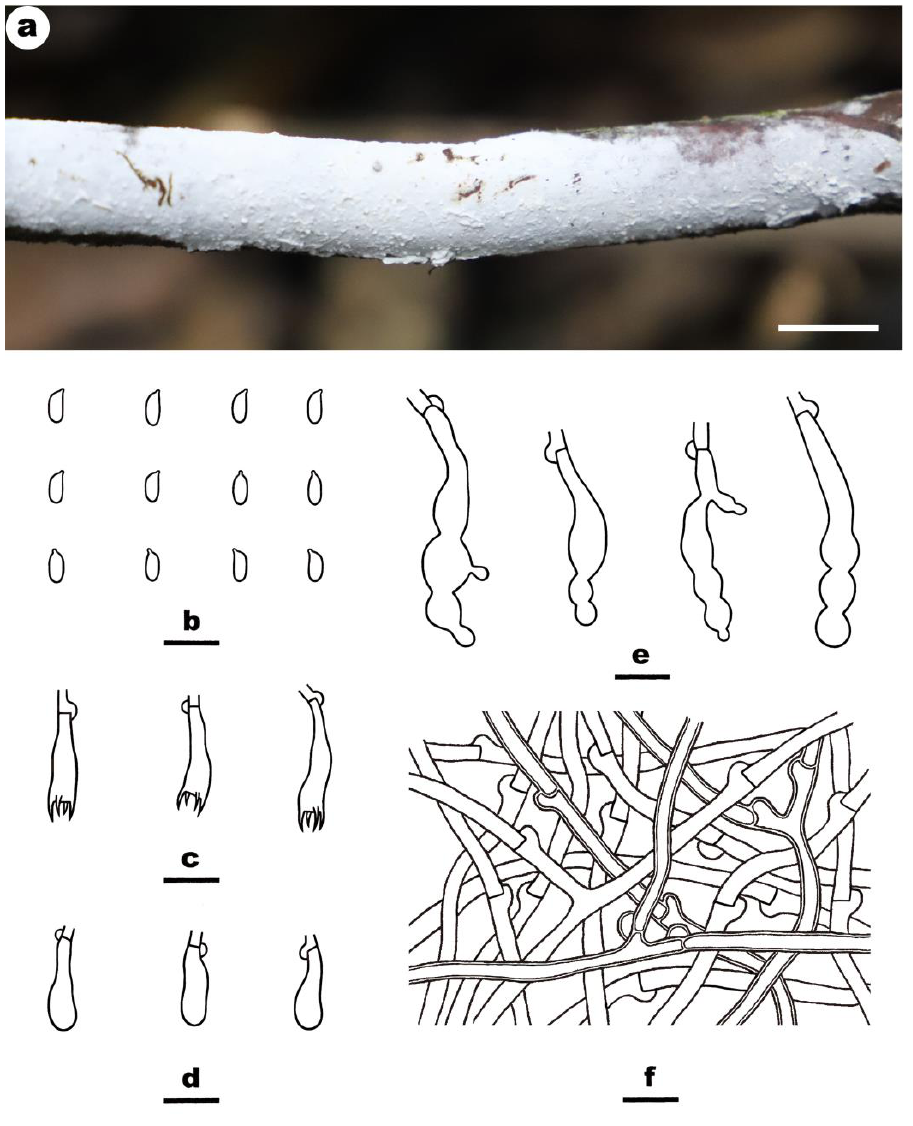
Figure 3. Crustomyces albidus (from the holotype BJFC 033109). Scale bars: ( a ) = 1 cm; ( b – f ) = 10 µm. ( a ). Basidiomes; ( b ). Basidiospores; ( c ). Basidia; ( d ). Basidioles; ( e ). Gloeocystidia; ( f ). Generative hyphae from subiculum.